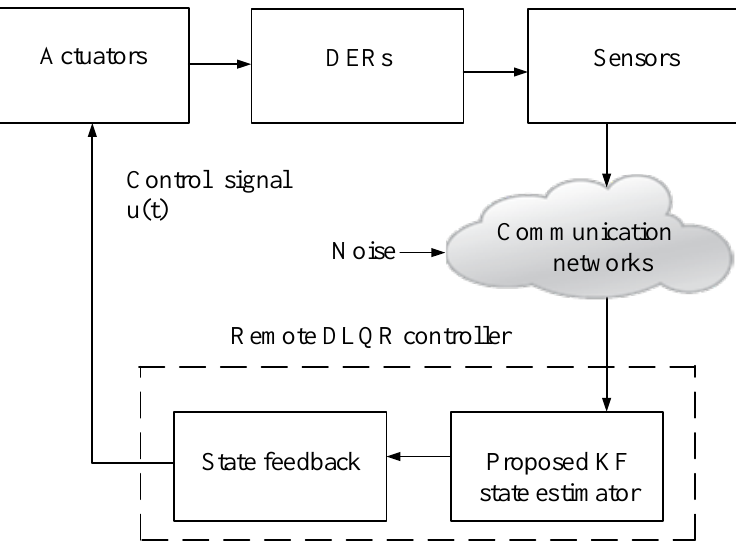
Figure 10. The role of the WSN in the optimization of the smart grid